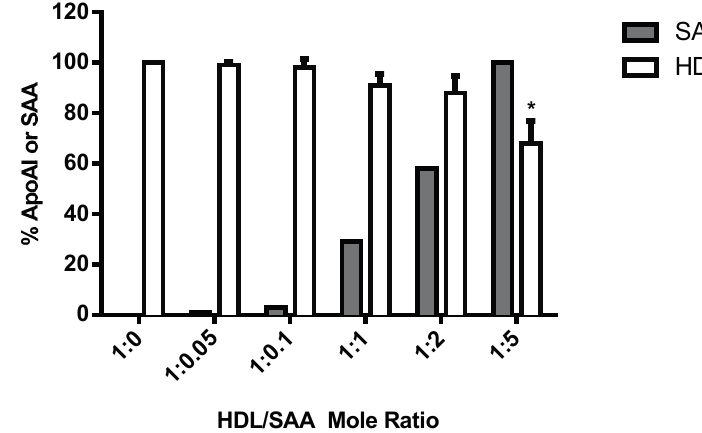
Figure 6. Changes in HDL apolipoprotein content in response to added SAA. The content of SAA (grey bar) and ApoA1 (white bar) in HDL were quantified using peak area analysis after separation with HPLC (see Figure 5). Changes in HDL apolipoprotein content were made after determining the maximal peak area response for ApoA-I and SAA and expressing peak areas as a percentage of that maximal area response (set to 100%). Data represent mean ± SD; n = 3 studies. * p < 0.05 compared to HDL in the absence of